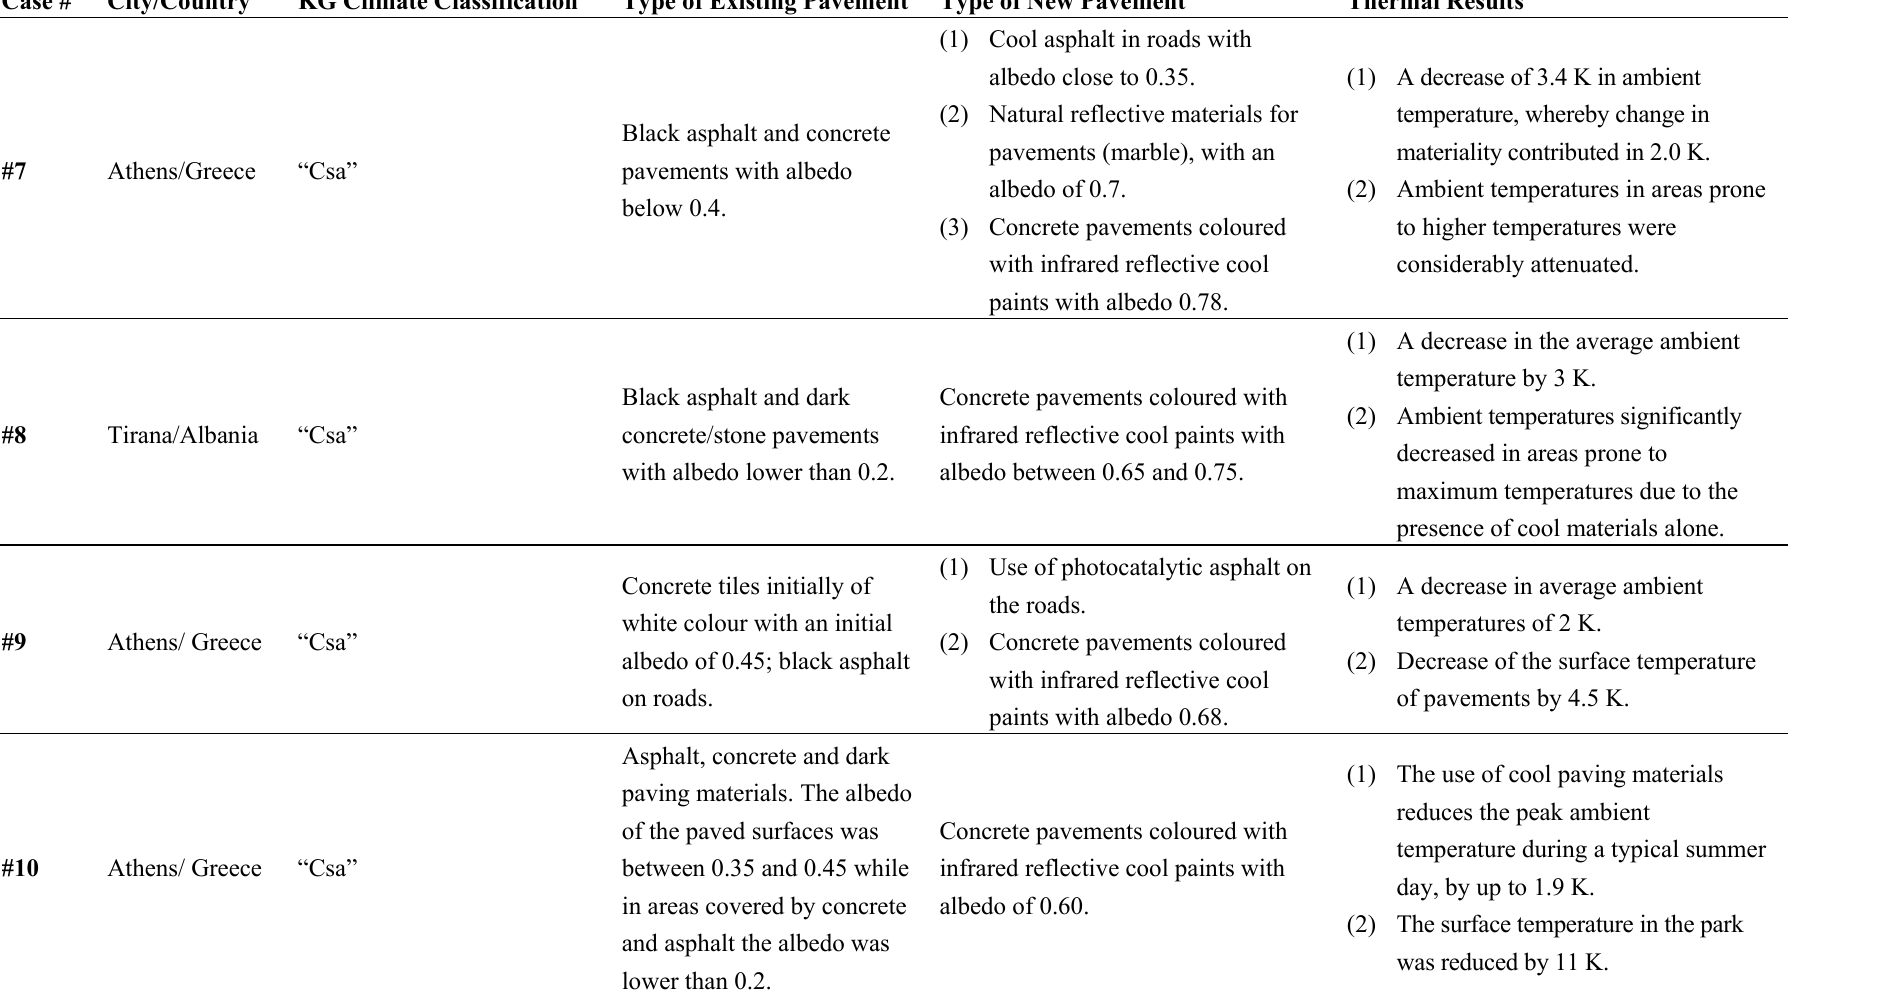
Table 2. Direct application of reflective pavements in existing bioclimatic projects. Adapted with permission from Elsevier